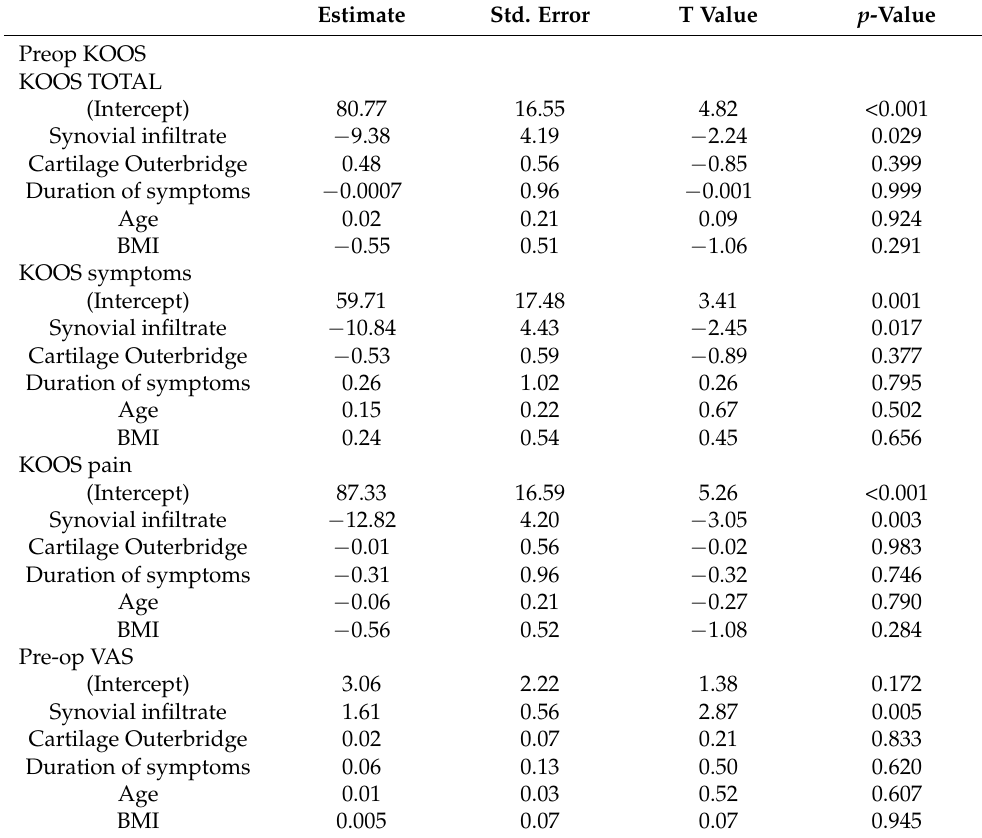
Table 2. Multivariate linear regression models between clinical outcomes and synovial infiltrate and the other OA risk factors.